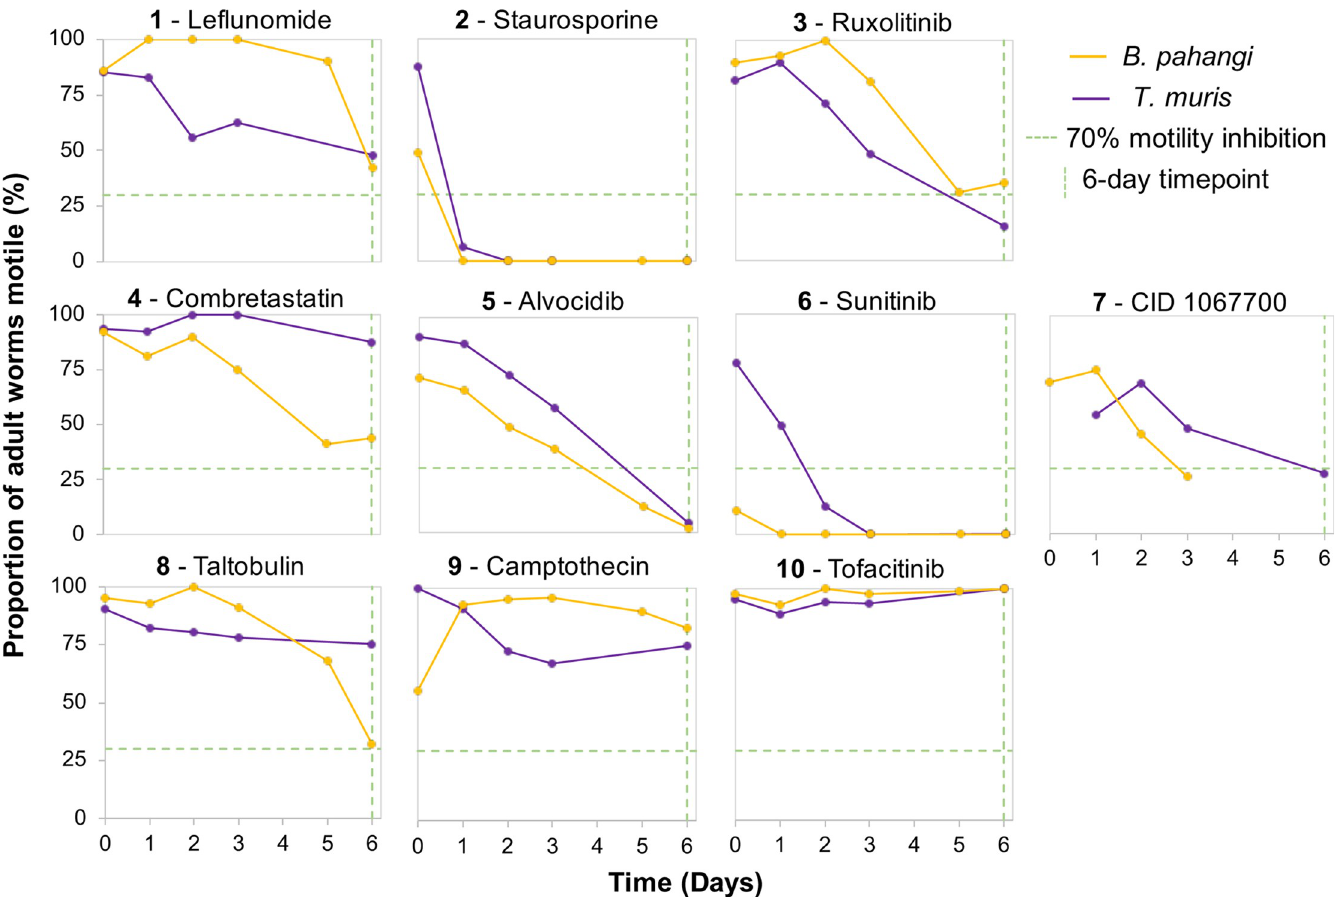
Fig 6. Motility responses of inhibitor treated B . pahangi and T . muris (100 μ M, except for Staurosporine at 25 μ M).